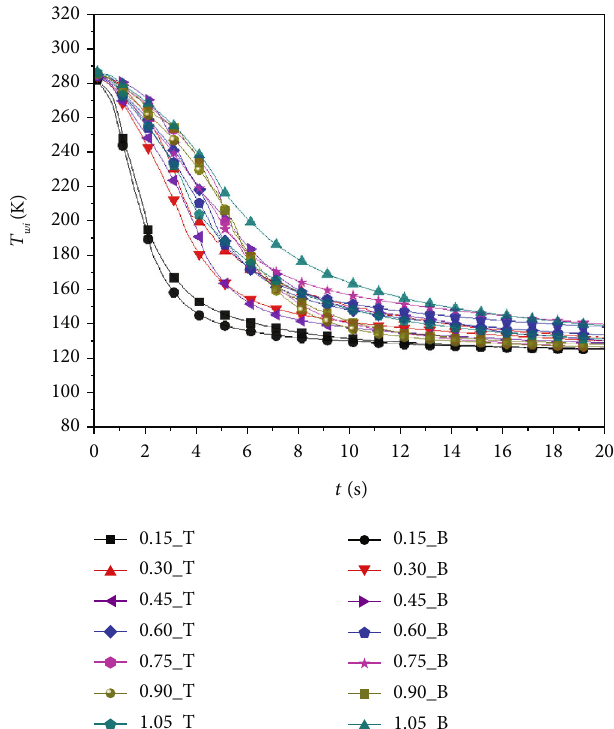
Figure 8: Data curves for Exp. 7 ( _ m = 0 : 549 kg/s , p